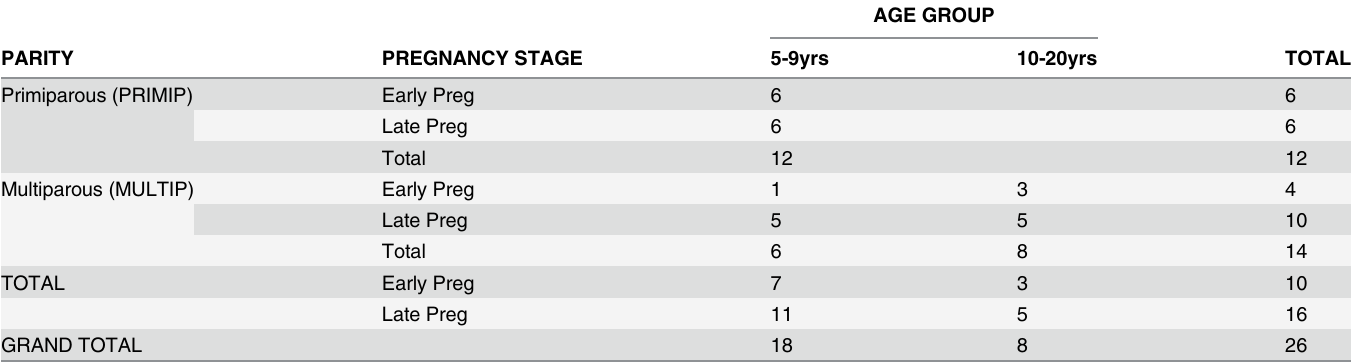
Table 1. Subject characteristics for this